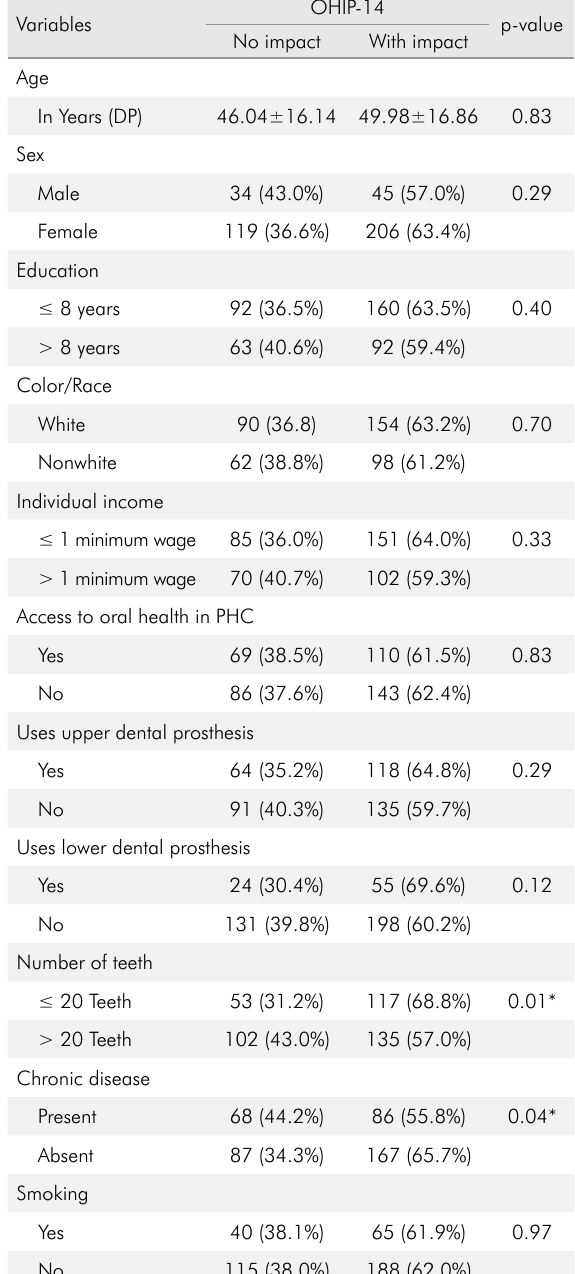
Table 2. Association between the OHIP-14 outcomes and the characteristics of users of primary health care services in the city of Porto Alegre, Rio Grande do Sul, Brazil, 2013 (n = 412).